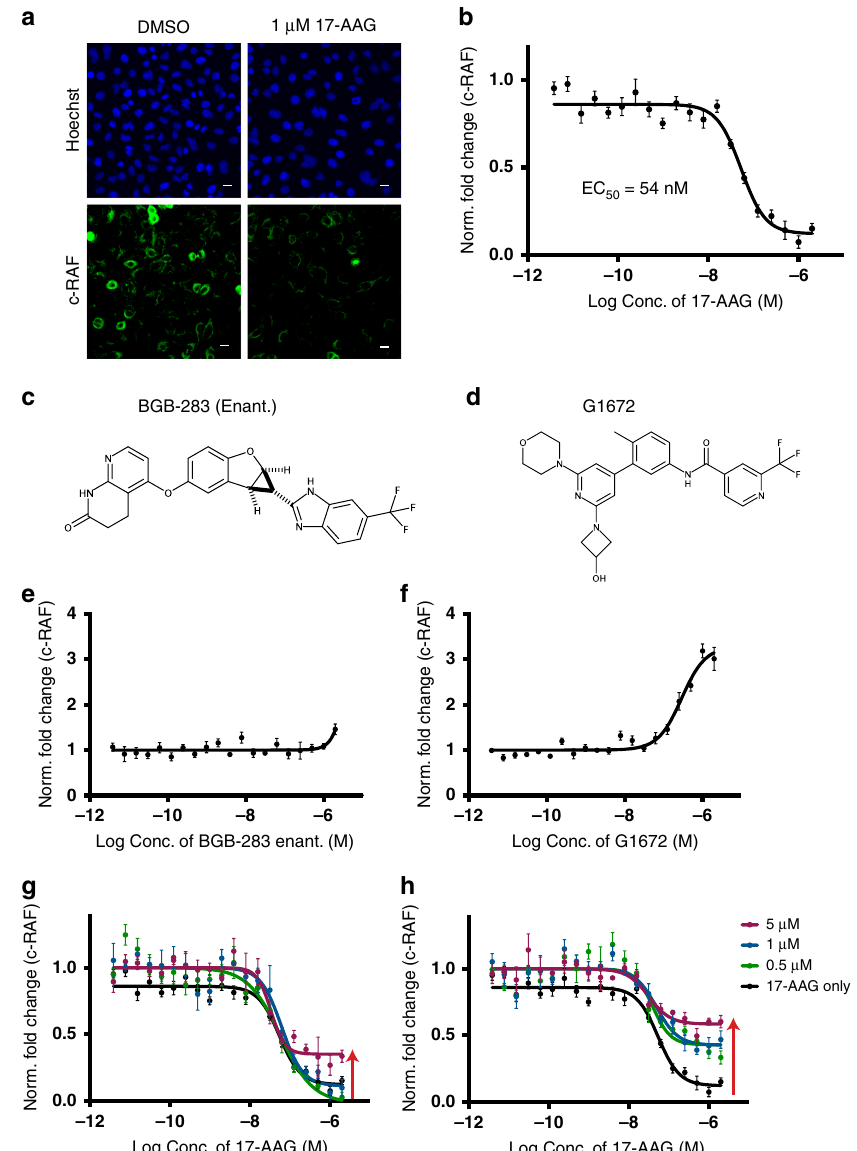
Fig. 2 Quantitative fl uorescence imaging measuring the effect of 17-AAG on c-RAF. a Immuno fl uorescence images of c-RAF protein in A549 cells treated with DMSO or 17-AAG (1 µ M) for 4 h. The upper panels show Hoechst 33342 staining of the DNA (blue) indicating the nuclear region, while the lower panels show the c-RAF immuno fl uorescence stain. Scale bar − 20 μ m. b The change in mean c-RAF protein per cell (A549 cells) was calculated for a range of concentrations of 17-AAG and expressed relative to the c-RAF level in DMSO treated samples and the no primary antibody control sample.